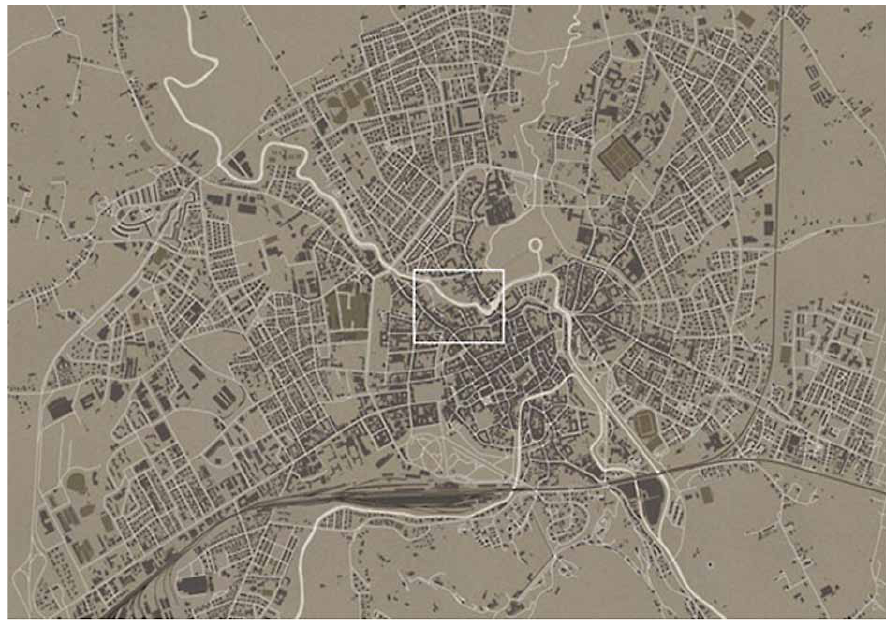
fig. 2b. Map of Vicenza, showing the position of the study area at the north-west limit of the historic city center (Pozzato